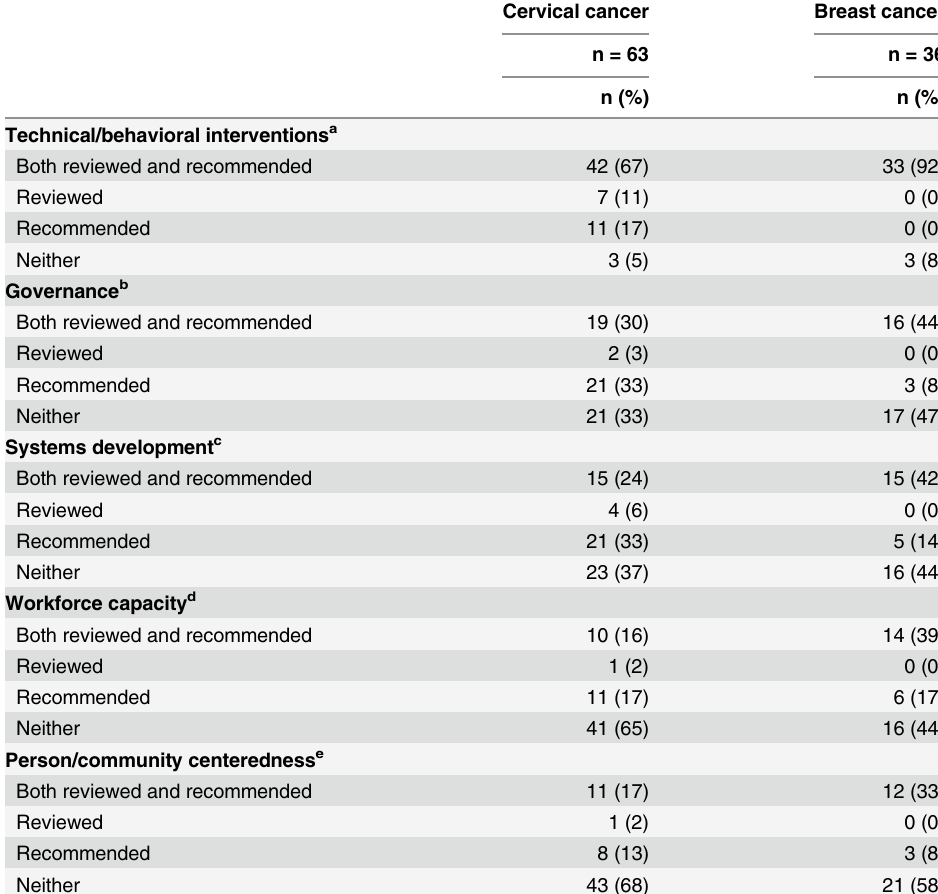
Table 3. Emerging thematic areas from breast and cervical cancer reviews in low- and middle-income countries (LMICs).